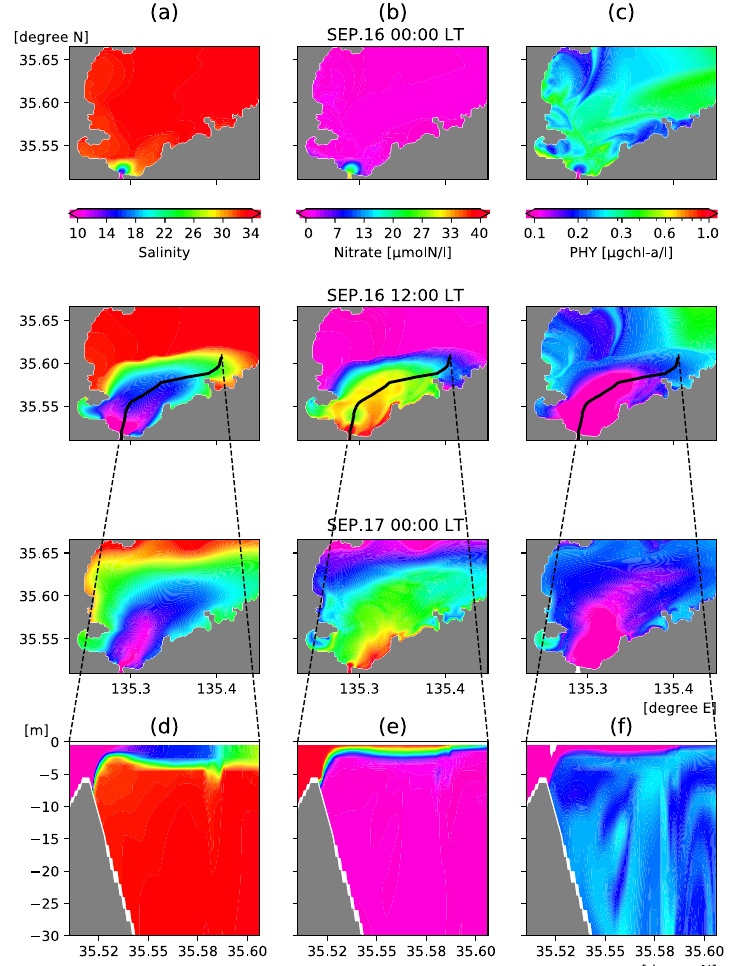
Figure 3. Surface (top two layers) mean distributions of ( a ) salinity, ( b ) nitrate, and ( c ) phytoplankton of WOS (the case without SSM). The time shifts from 00:00 local time (LT) on September 16 (top panels) to 00:00 LT on September 17 (third row of panels from the top), 2013. Bottom panels depict vertical ( d ) salinity, ( e ) nitrate, and ( f ) phytoplankton distributions along the center section of the river plume indicated by the black lines on the second row of panels. The black line marks the main streamline of the riverine output flows determined by the flow speed and the sea surface height maxima. The ecosystem model runs on a nitrogen basis. Unit conversion from nitrogen (μmolN/l) to chl. a (μg-chla/l) is the same way as OY05 28 . This figure was prepared with matplotlib ver. 3.3.1 in Python ver.